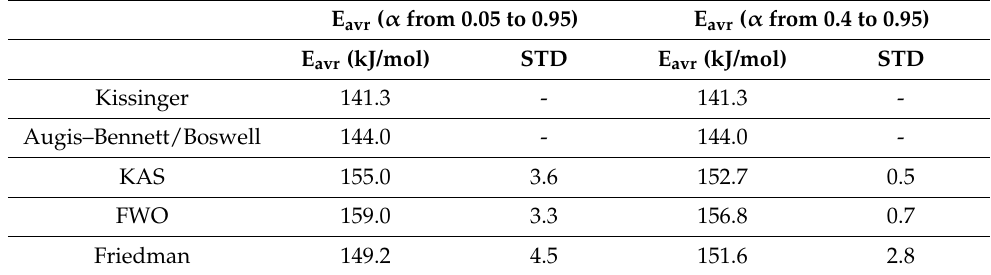
Table 4. The average activation energy values for EPDM host composite loaded with 100 phr lead.